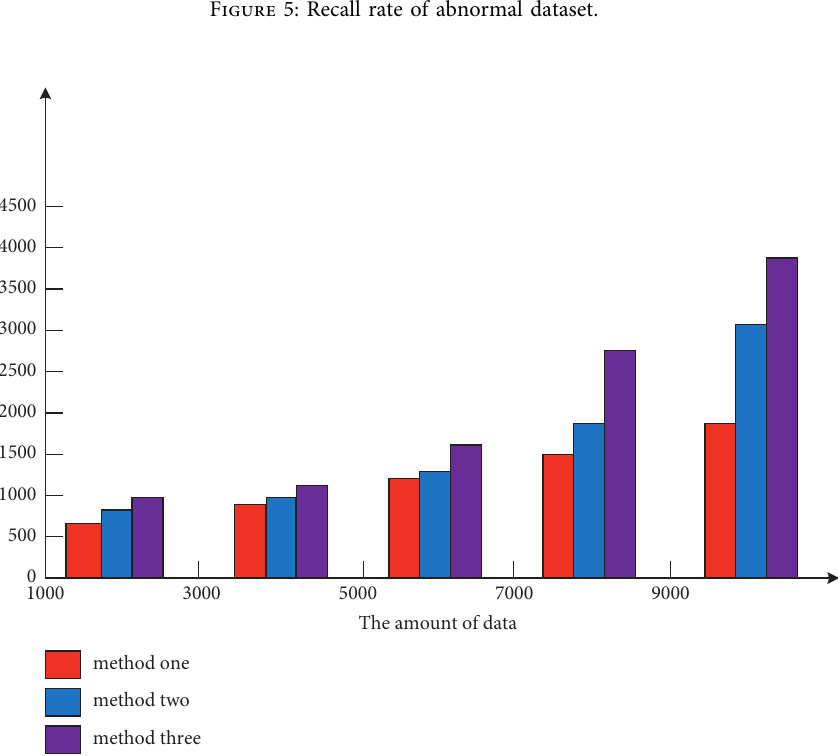
Figure 5: Recall rate of abnormal